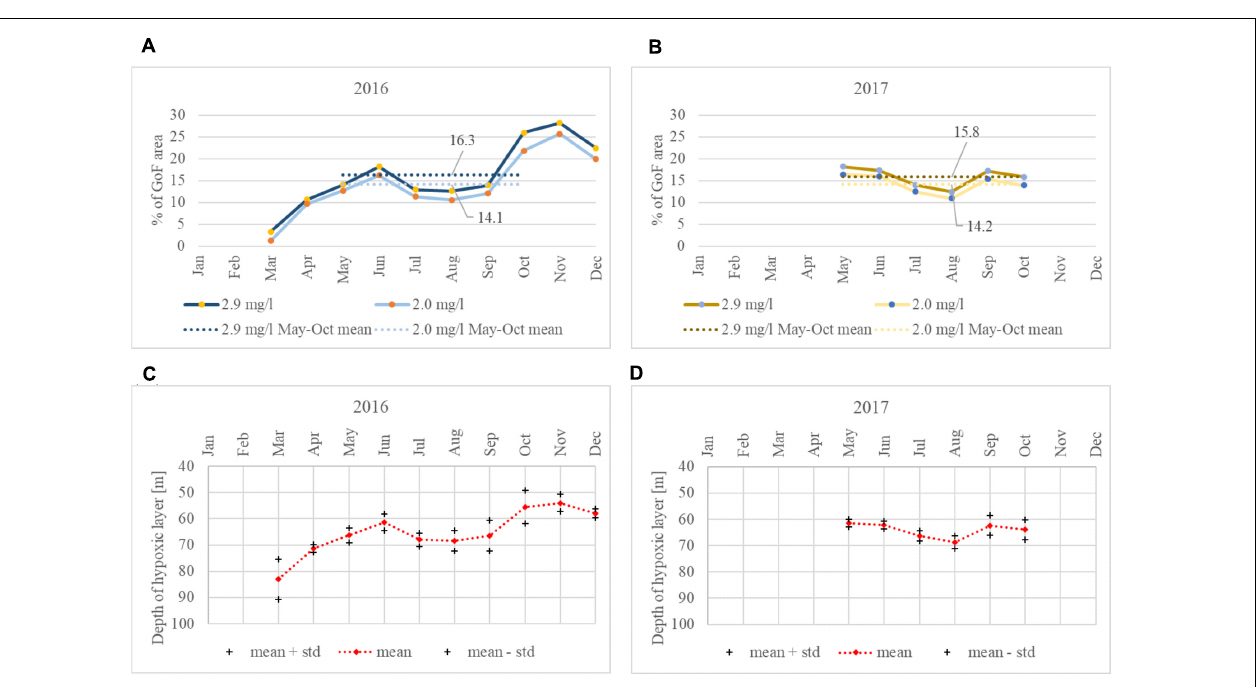
Frontiers in Marine Science |